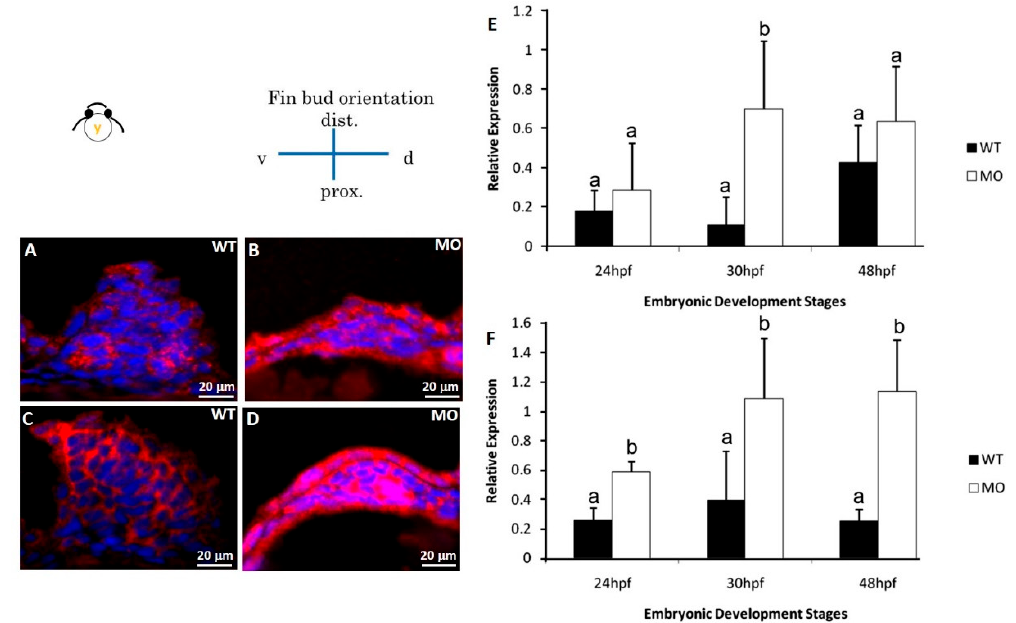
Figure 7. Immunohistochemical staining of apoptosis-related proteins. Pectoral fins were stained with apoptosis-related (BAD and BCL2) antibodies (red) and counterstained with DAPI (blue) to observe the nucleus. BAD ( B ) and BCL2 ( D ) proteins were significantly uninhibited in the tbx5a morphant group compared with those in the Uninjected group ( A , C ). The embryo anterior is shown on the left. The Bad ( E ) and Bcl2 ( F ) expression in the tbx5a morphant group was significantly uninhibited at 24, 30, 36, and 48 hpf ( n = 50, triplet) ( E ). hpf, hours postfertilization; WT, Uninjected group; MO, tbx5a morphant group. a, b: A significant difference was detected by a, b: A significant difference